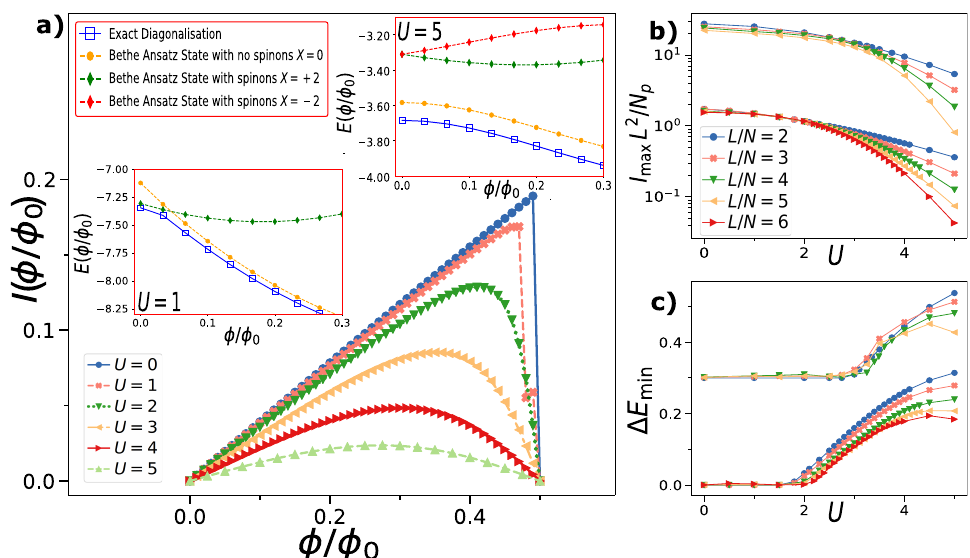
Figure 3: SU( N ) persistent current I ( φ ) at integer filling. a) I ( φ ) for N = 3, L = 9 against flux φ . Insets display BA results of the Sutherland-Lai model for different = L = 6 compared with exact diagonal- spinon configurations X for N = 3 and N p ization. The ground state energy at small φ can only be reached with spinon Bethe = max ( I ) for N = 3 quantum numbers configuration. b) Maximal current I φ max (lower curves) and N = 4 (upper curves, shifted by factor 20) plotted against U c) Minimal energy gap E against U for N = 3 (lower curves) and N = 4 (upper min curves, shifted by 0.3). All curves with L > 9 were calculated with